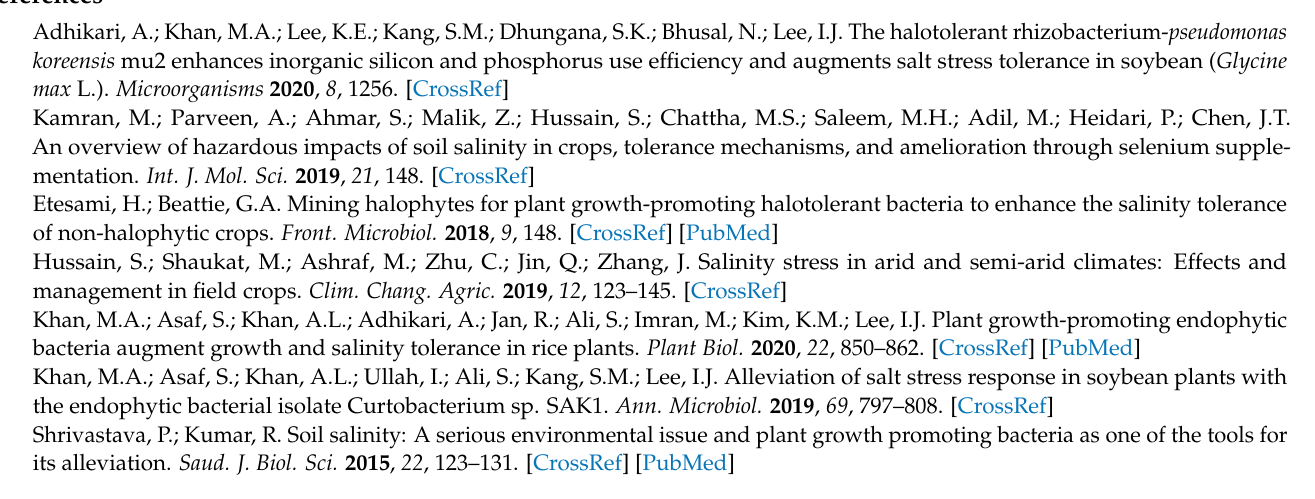
quantification of the Gas, Table S2: C/MS–SIM conditions used for analysis and quantification of IAA, Table S3: Screening test of Si impact on maize with different concentrations of Si (1 mM, 2 mM, and 3.mM), Table S4: GC/MS–SIM conditions used for analysis and quantification of the ABA and